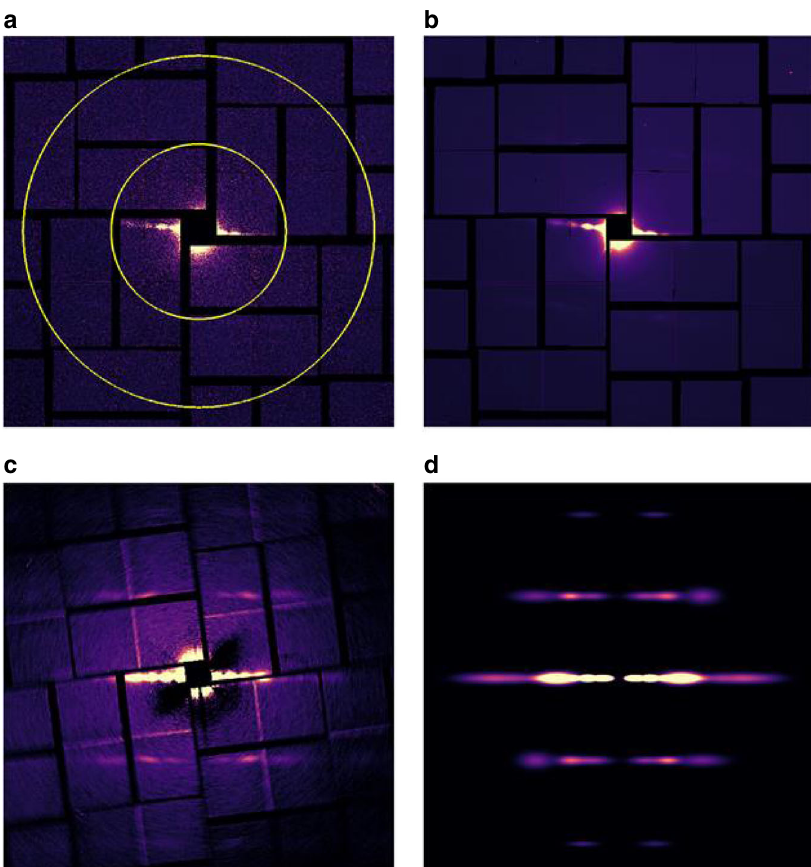
Fig. 2 X-ray diffraction images and class averages. a X-ray diffraction image recorded from exposure of microtubule samples to a single XFEL pulse. The inner yellow circle indicates 4 nm resolution and the outer circle indicates 2 nm resolution. This scale applies to all panels. b Average of approximately 200 images selected by class average sorting of the X-ray diffraction patterns using software originally developed for electron microscopy applications 36 . c Sum of the class averages (13,511 images summed in total) after aligning each class average by rotating about the beam center. d Fitted diffraction image recovered by fi tting Gaussian peaks to the features identi fi ed as diffraction peaks in ( c